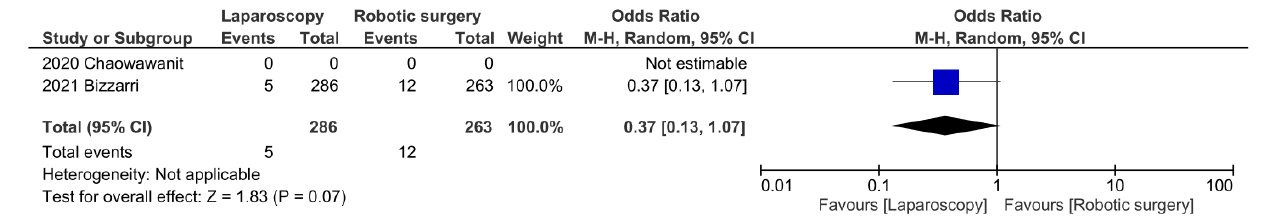
Figure 10. Forest plot of individual and pooled odds ratios, with 95% confidence interval (CI), for intraoperative complications, comparing laparoscopy and robotic surgery for SLN biopsy in EC women.